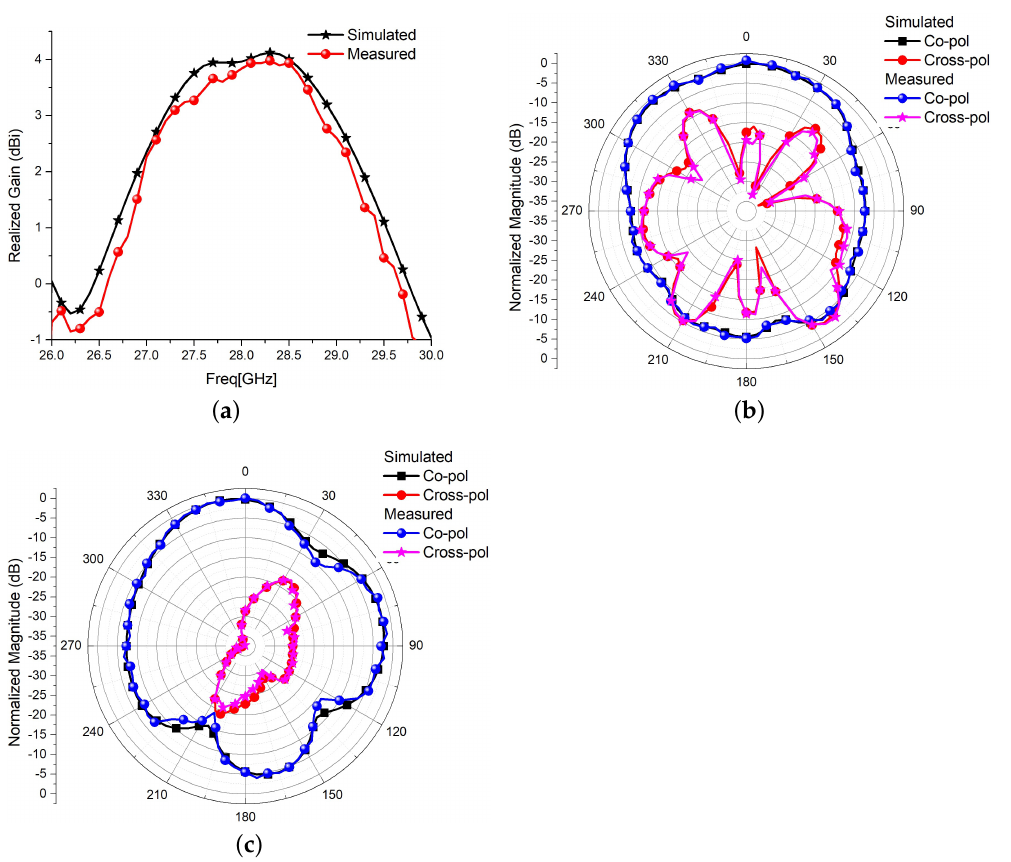
Figure 15. Measured results ( a ) Gain ( b ) Broadside E-plane radiation at 28 GHz ( c ) Broadside H-plane radiation at 28 GHz.